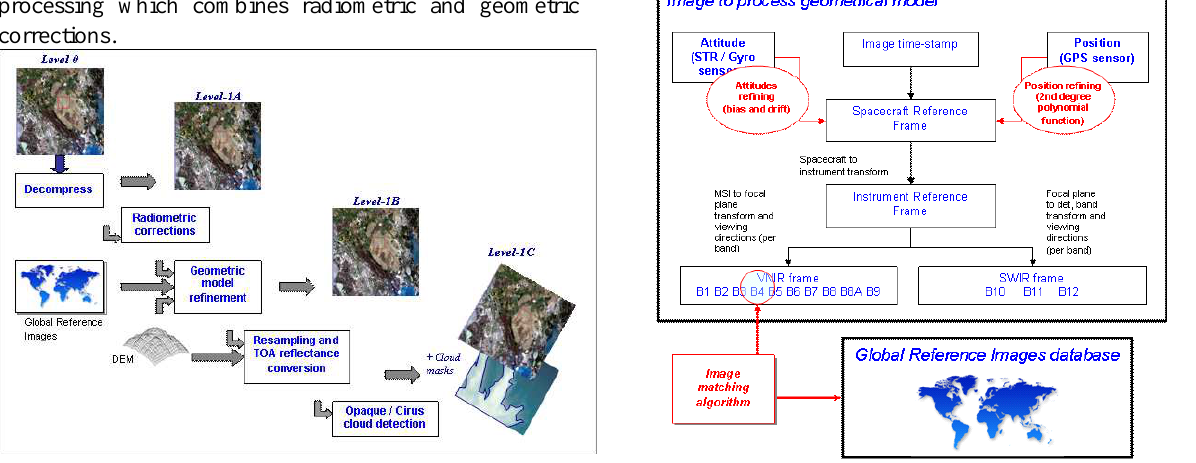
Figure 4: Level-1 processing workflow